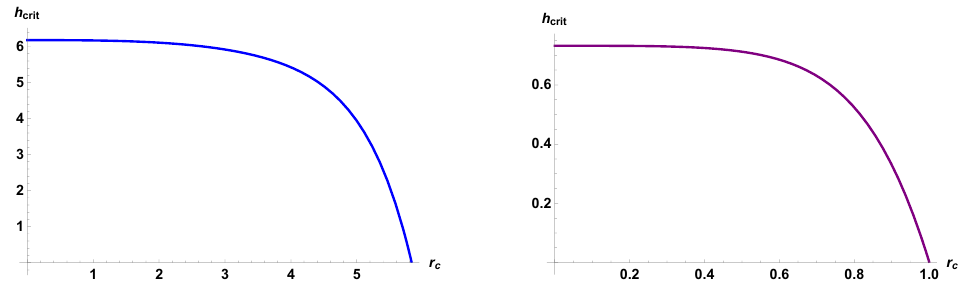
Figure 16 . h crit . as a function of r c for: Left ) ‘ = 10 and d e = 2 . Right ) ‘ = 1 and d e = 3 . Notice that these diagrams are based on eqs. (4.12) and (4.14) which are valid for ‘ (cid:29) r